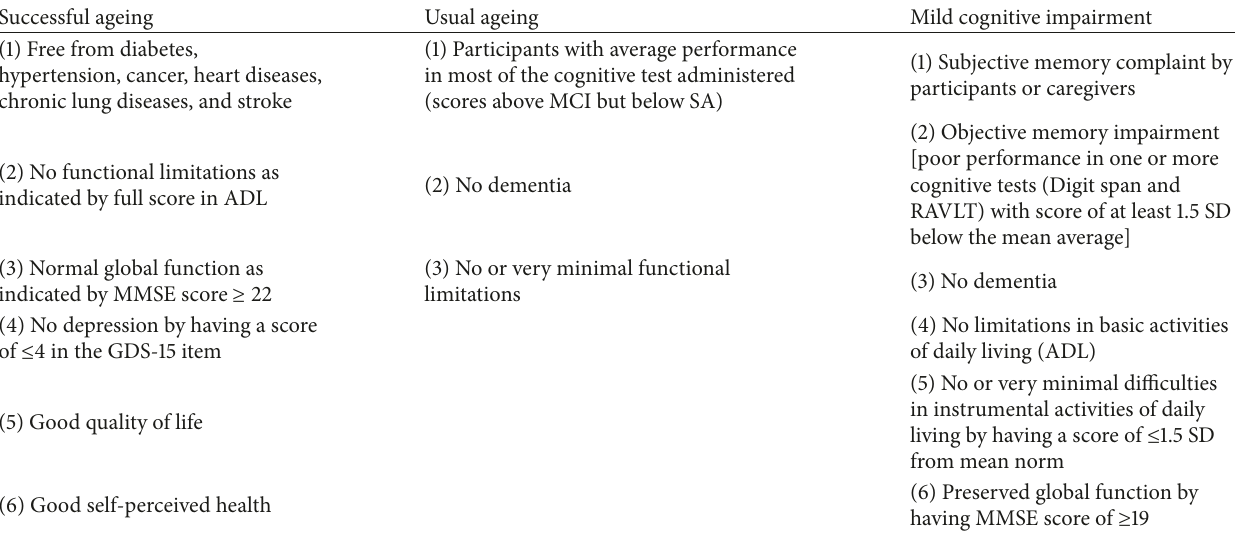
Table 1: Classification criteria for ageing